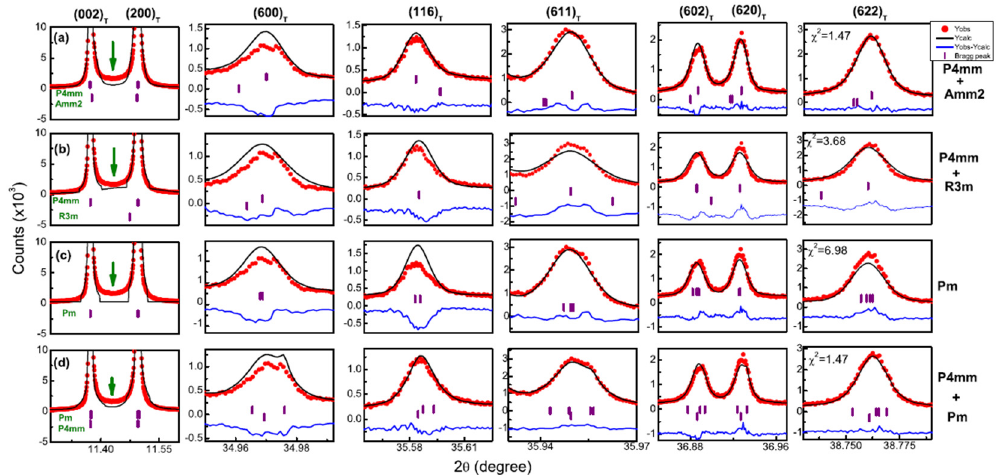
Figure 4. Rietveld fitted synchrotron high-resolution XRD profiles of BaTiO 3 with models ( a ) P 4 mm + Amm 2, ( b ) P 4 mm + R 3 m , ( c ) Pm , and ( d ) P 4 mm + Pm . Best fitting model is P 4 mm + Pm . Reproduced with permission from [32].